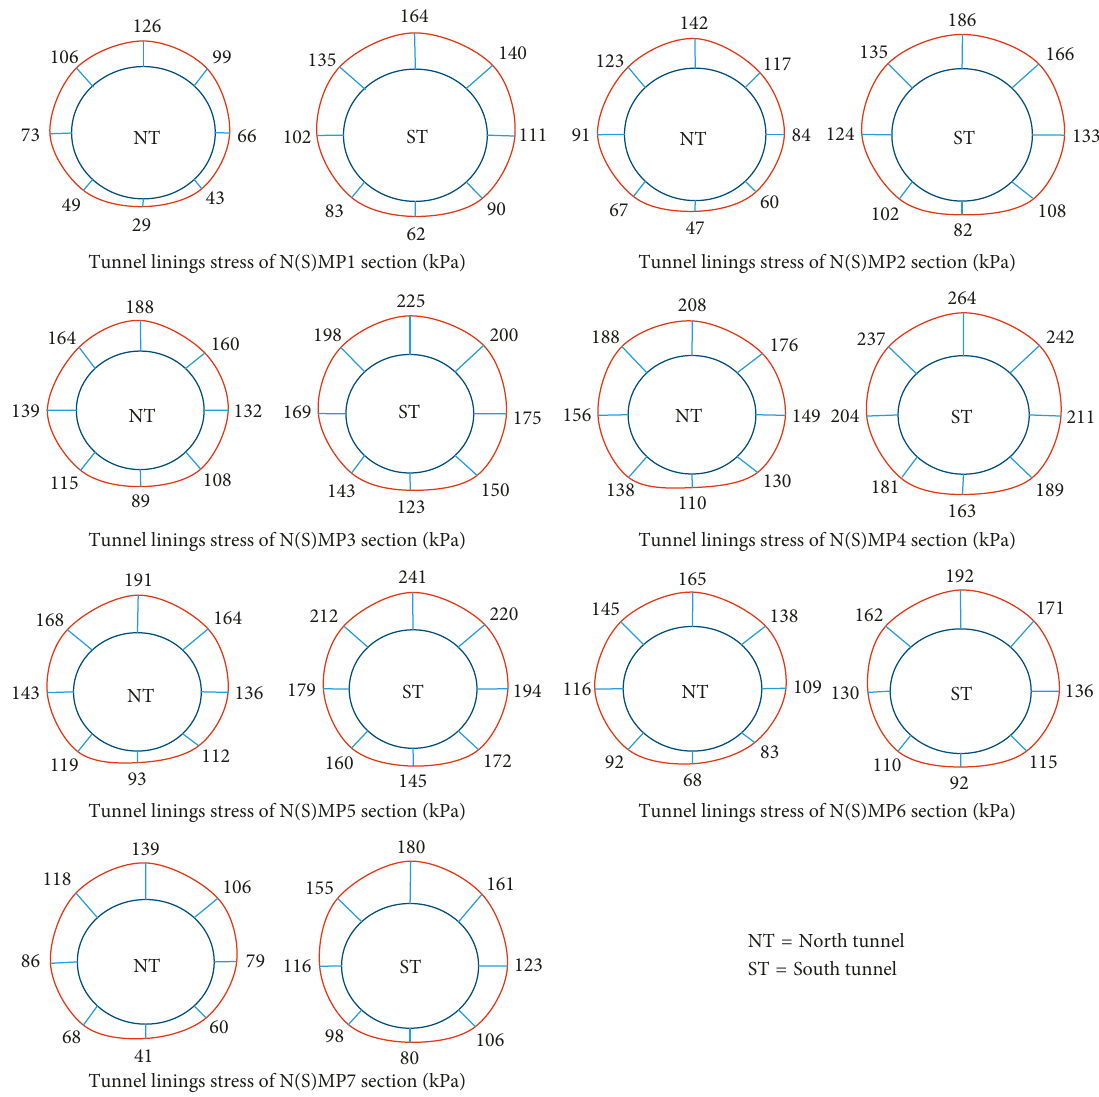
Figure 14: Stress distribution in linings of existing tunnels.